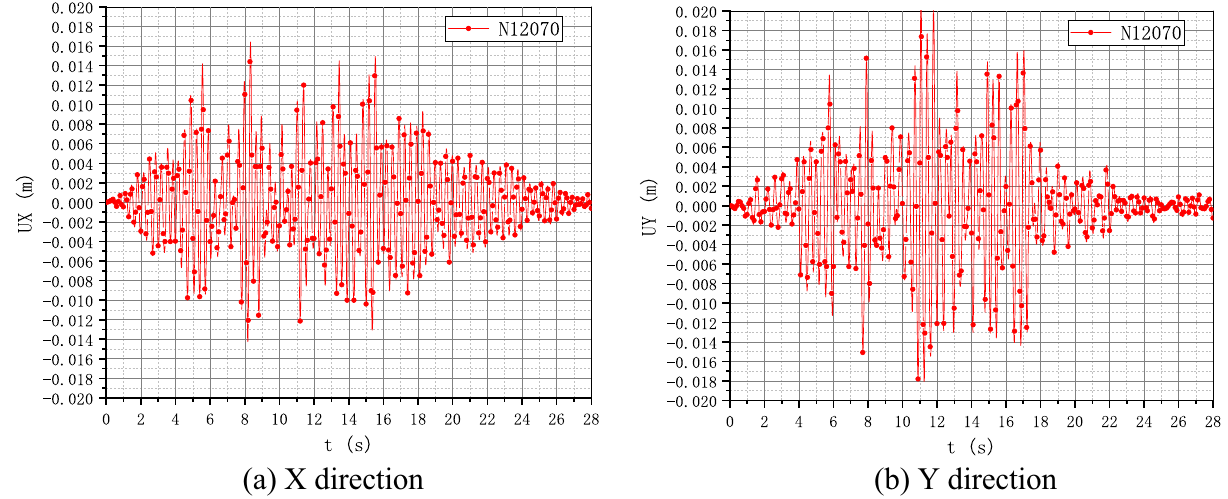
Figure 28. Relative horizontal displacement histories of the points on the top of the shield building. ( a ) X direction, ( b ) Y direction.